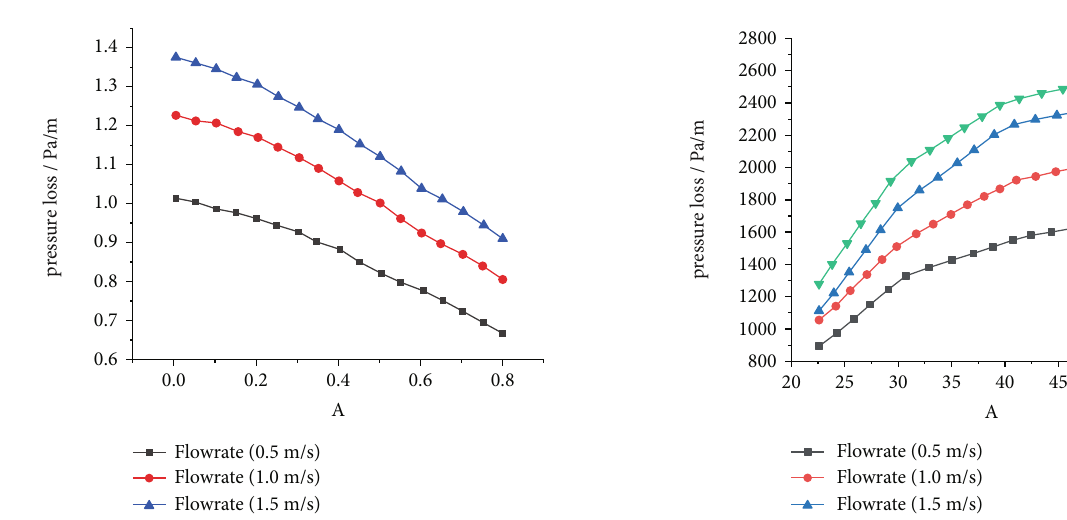
Figure 7: E ff ect of eccentricity on the pressure loss with various fl owrates. Figure 8: E ff ect of gap width on the pressure loss with various